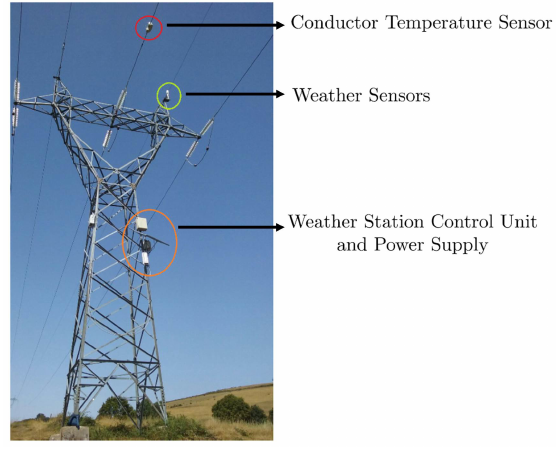
Figure 3. An example of an installation of a weather station on a transmission tower.